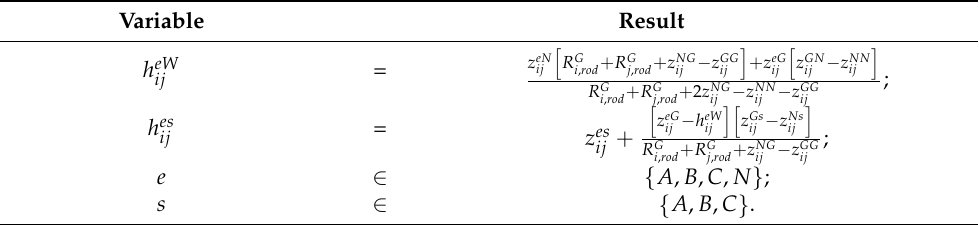
Table 2. Variable results from solving Equation